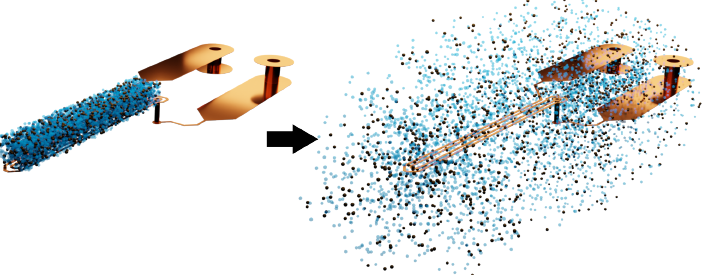
Figure 3. ( Left ) schematic representation of the sample (NPs and their embedding matrix) on top of the planar coil (here, the surrounding electronics and materials are not depicted) as used in experimental measurements and simulations; ( right ) scheme of the uniform particle distribution surrounding the coil as used in the mathematical model, with the same NPs and matrix